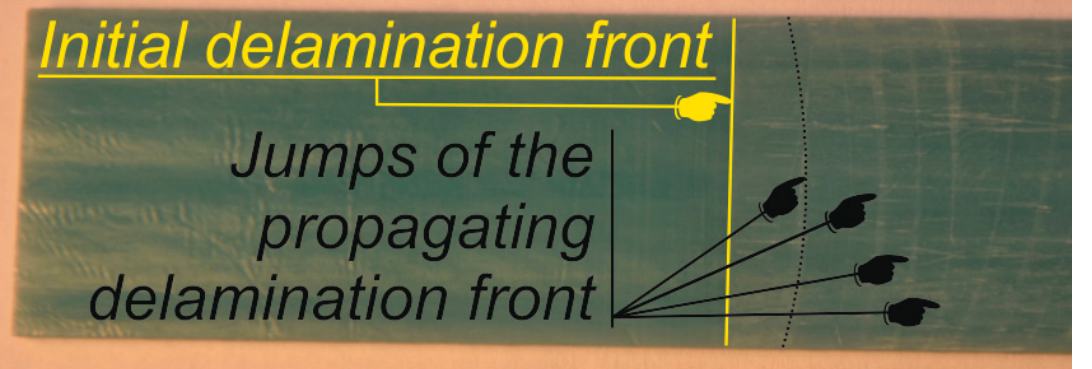
Figure 12. Scratches left by unstable crack propagation during DCB test.